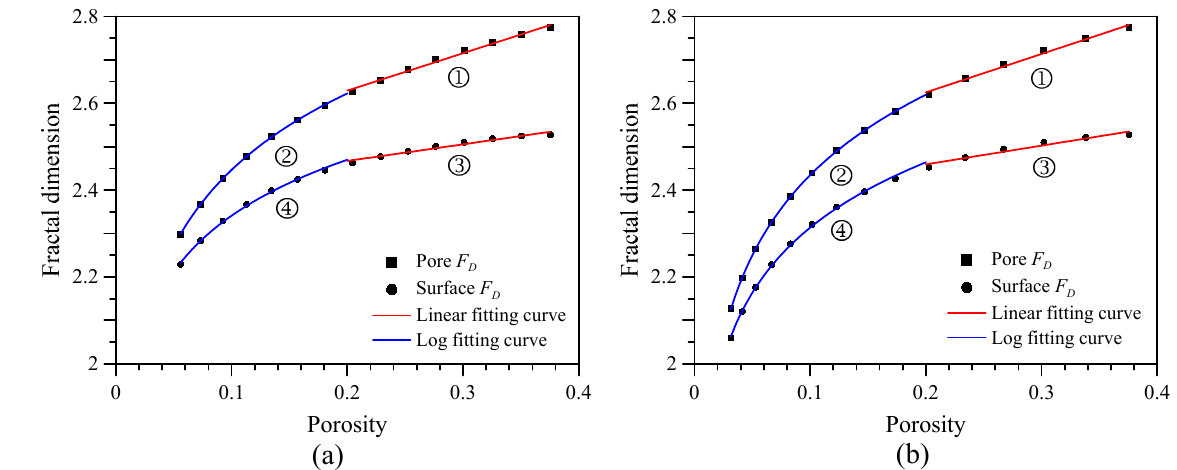
Table 3. Fitting equations of fractal dimensions.